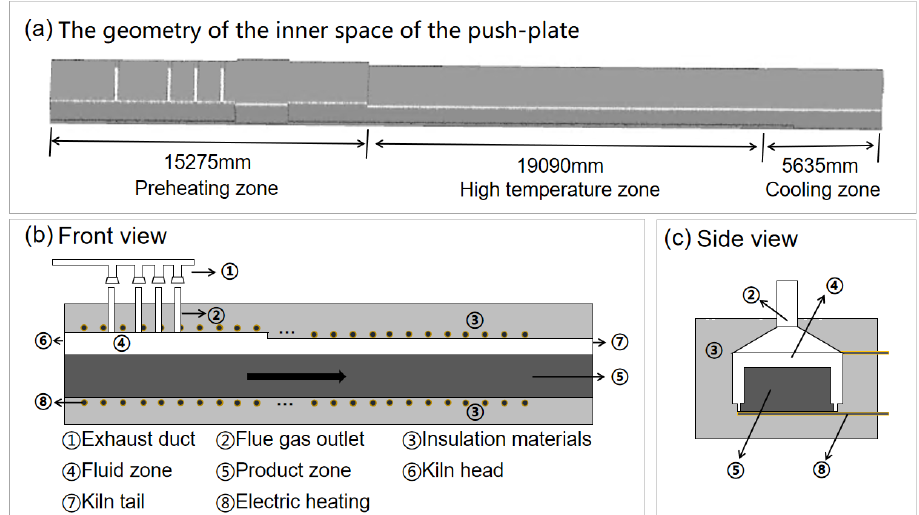
Figure 7. The structure of push-plate kiln. ( a ) shows the geometry of the kiln interior space. ( b ) is the front view of the kiln and ( c ) is the side view of the kiln.